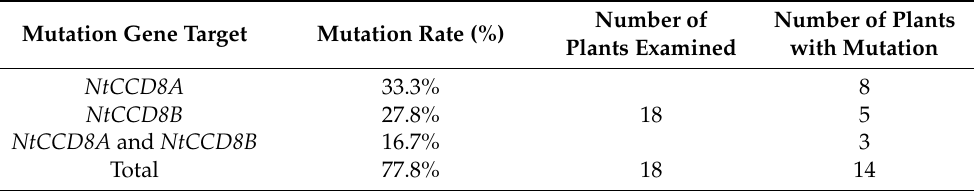
Table 1. Percentage of transgenic T 0 plants with mutations in NtCCD8 genes produced using the CRISPR/Cas9